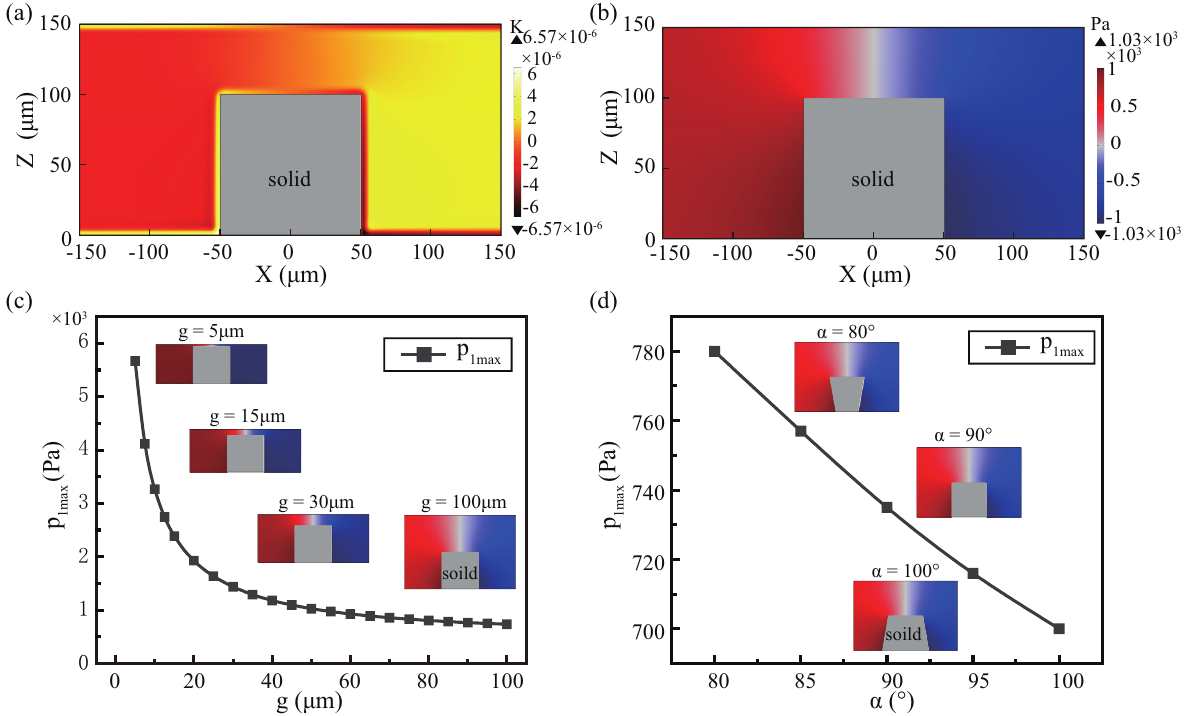
Figure A3. First − order acoustic field simulation.Microstructural vibrations can cause changes in the temperature ( a ) and sound pressure ( b ) of the fluid in the channel, where the gap is fixed at 50 µ m. In addition, the side profile can change the size and distribution of the sound pressure, including the gap ( c ) and the side angle ( d ), where the inset shows the sound pressure distribution.Where f = 10 kHz, η = 0.89